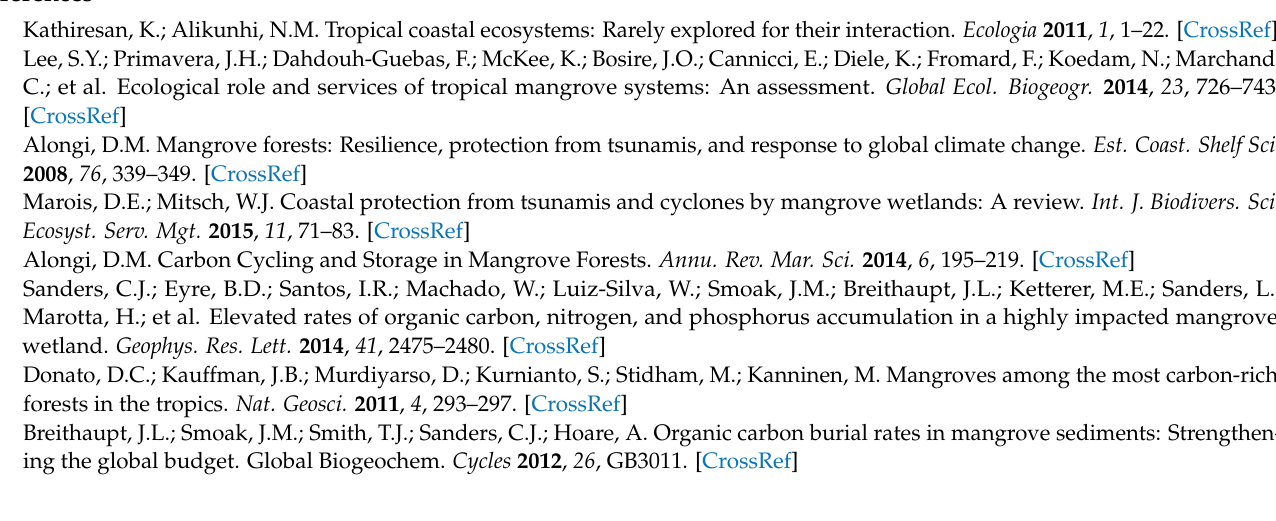
Table S4. Spearman correlations for geochemical variables within mangrove and saltmarsh zones. Only significant correlations ( p < 0.05) were